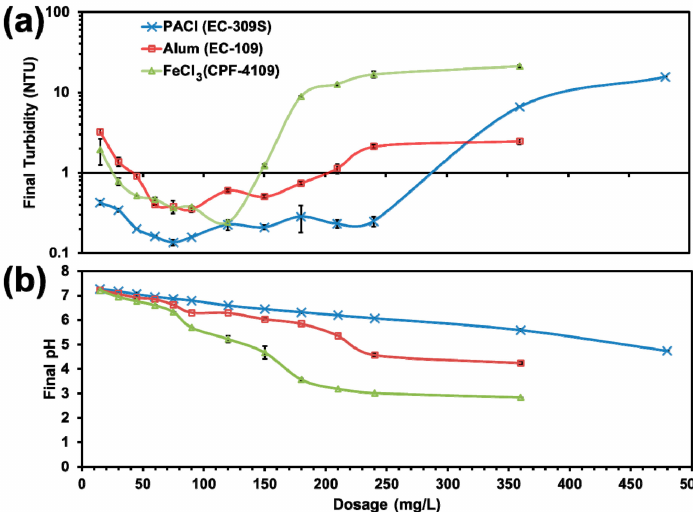
Figure 7. ( a ) Turbidity removal by three coagulants at various dosages; ( b ) pH changes for three coagulants at various doses. (Temperature = 7 ◦ C, initial pH = 7.47, initial turbidity = 70.00 NTU, initial TOC = 6.14 mg · L − 1 ; data plotted as mean of duplicates and error bars calculated as standard deviation to indicate data